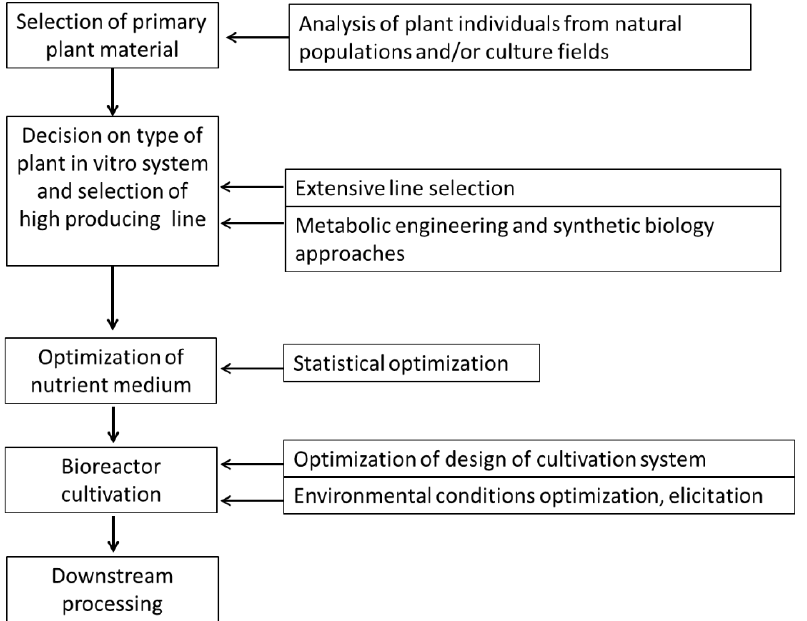
Figure 1. Integrated approach to biotechnological production of Amaryllidaceae alkaloids.